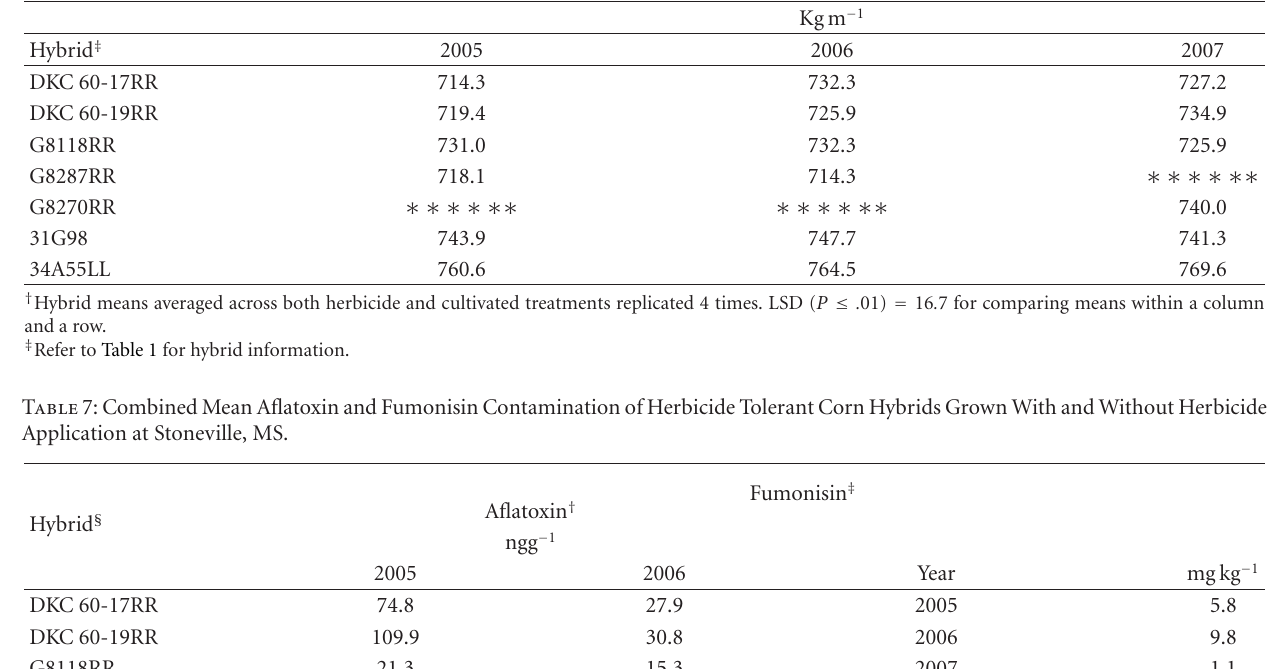
Table 6: Combined Mean Grain Bulk Density of Herbicide Tolerant Corn Hybrids Grown With and Without Herbicide Application at Stoneville, MS. †